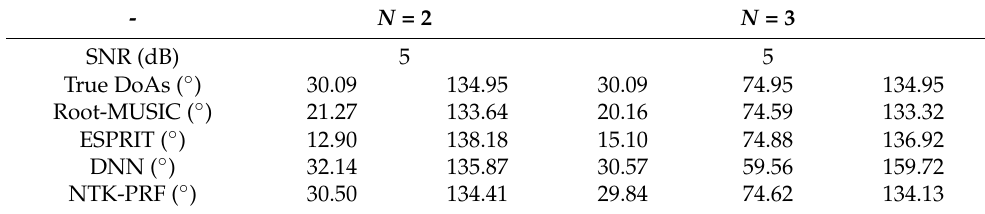
Table 4. Multiple signal DoA estimation.